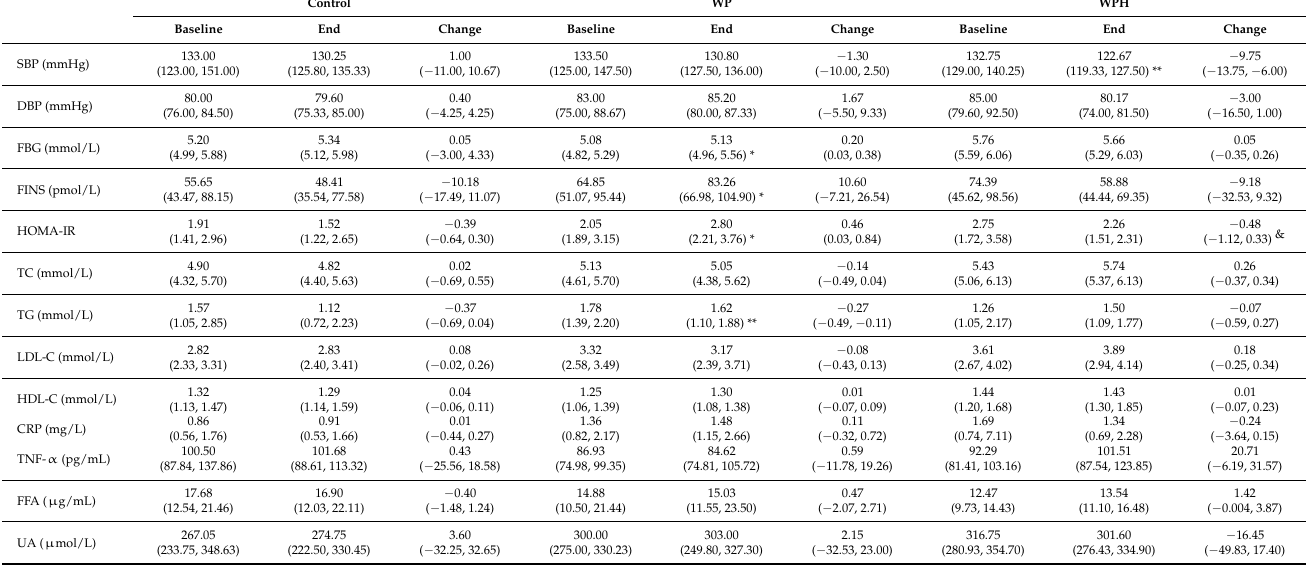
Table 4. The changes in biochemical blood markers among the three